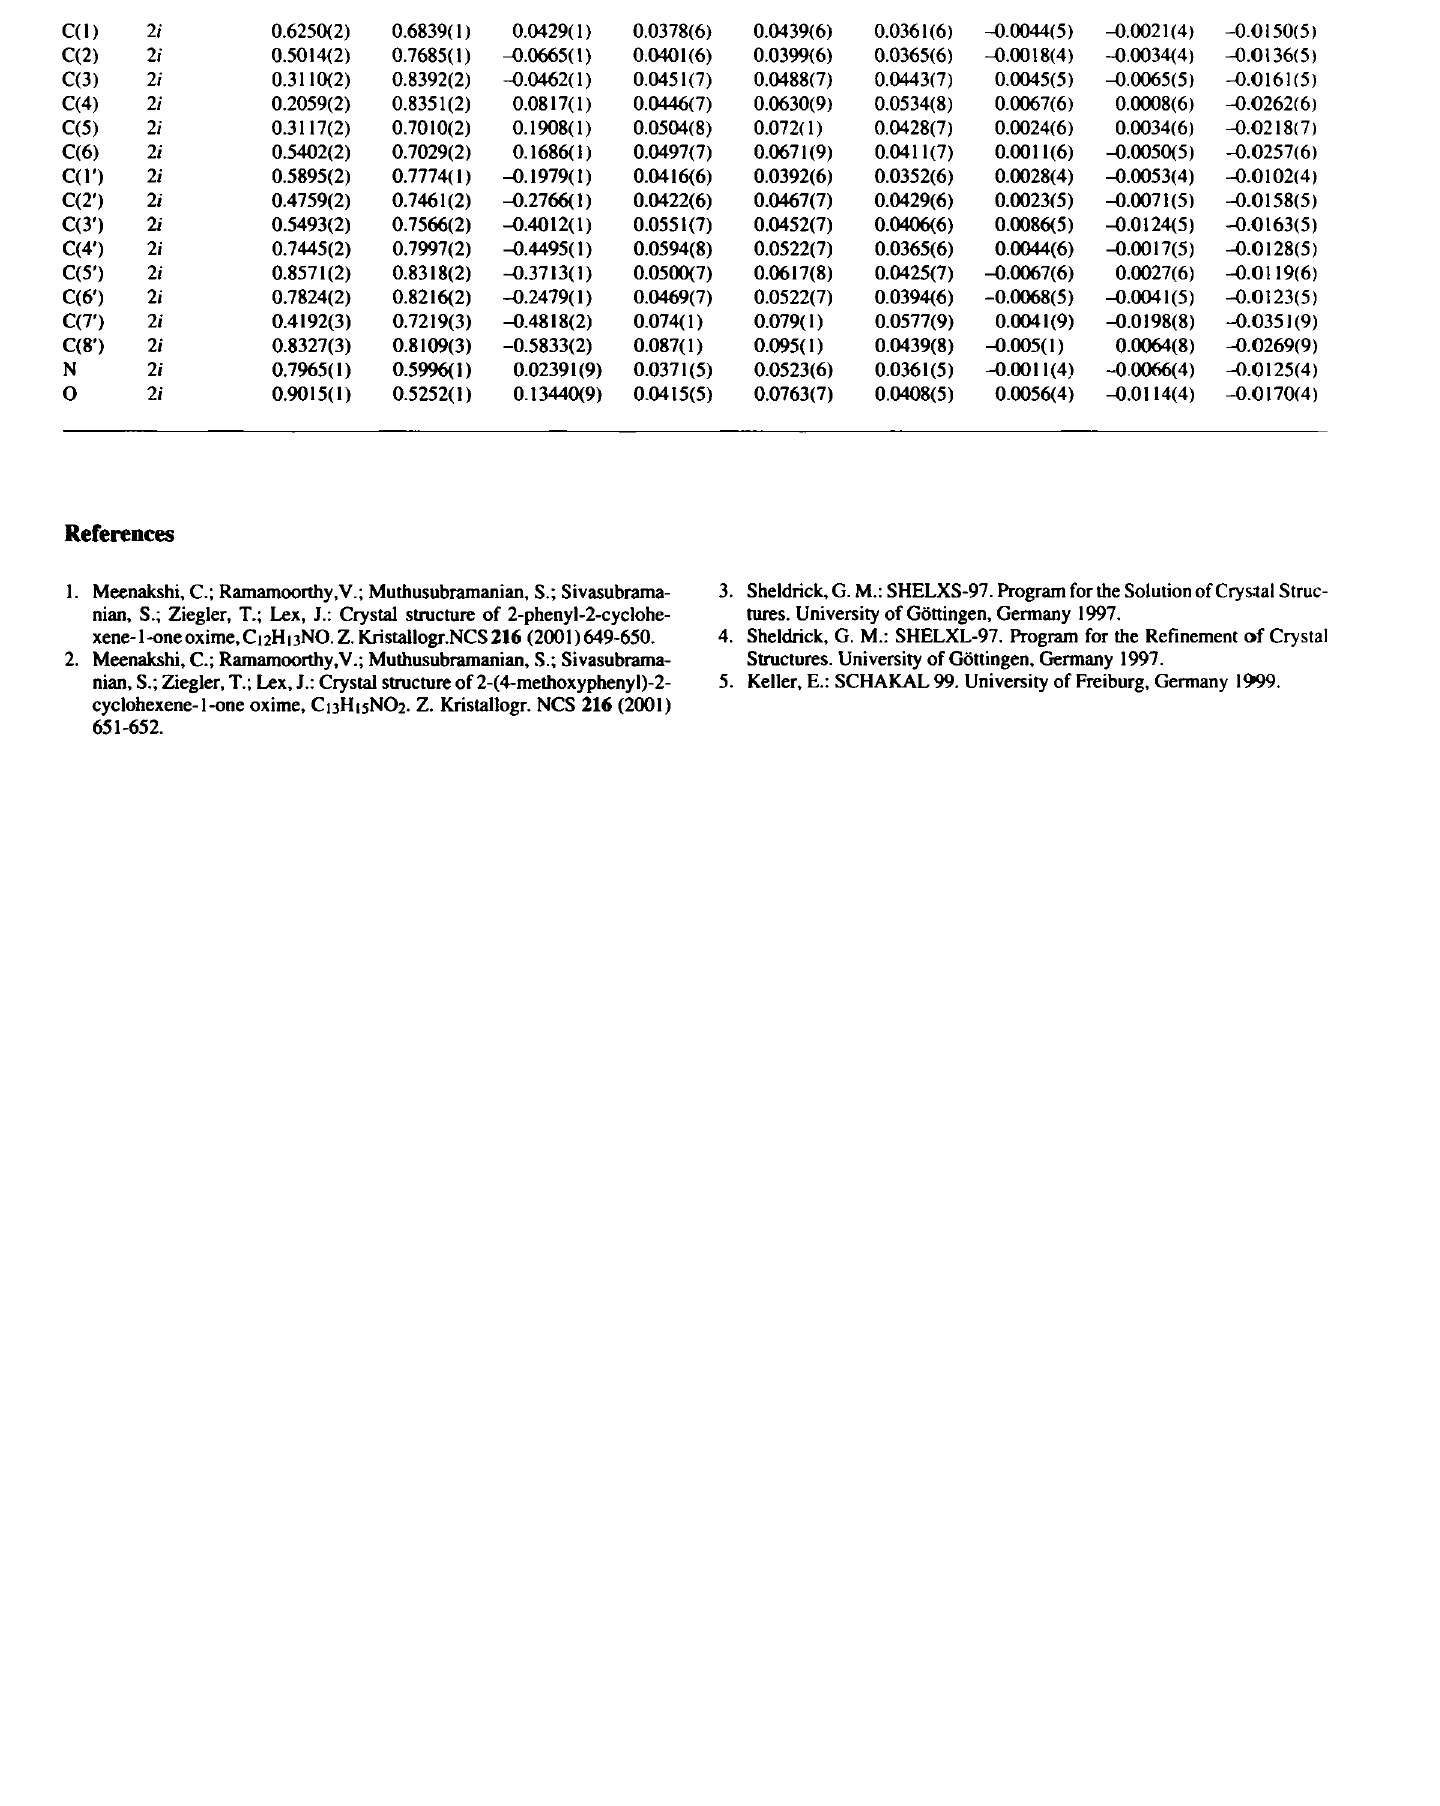
Table 3. Atomic coordinates and displacement parameters (in A 2